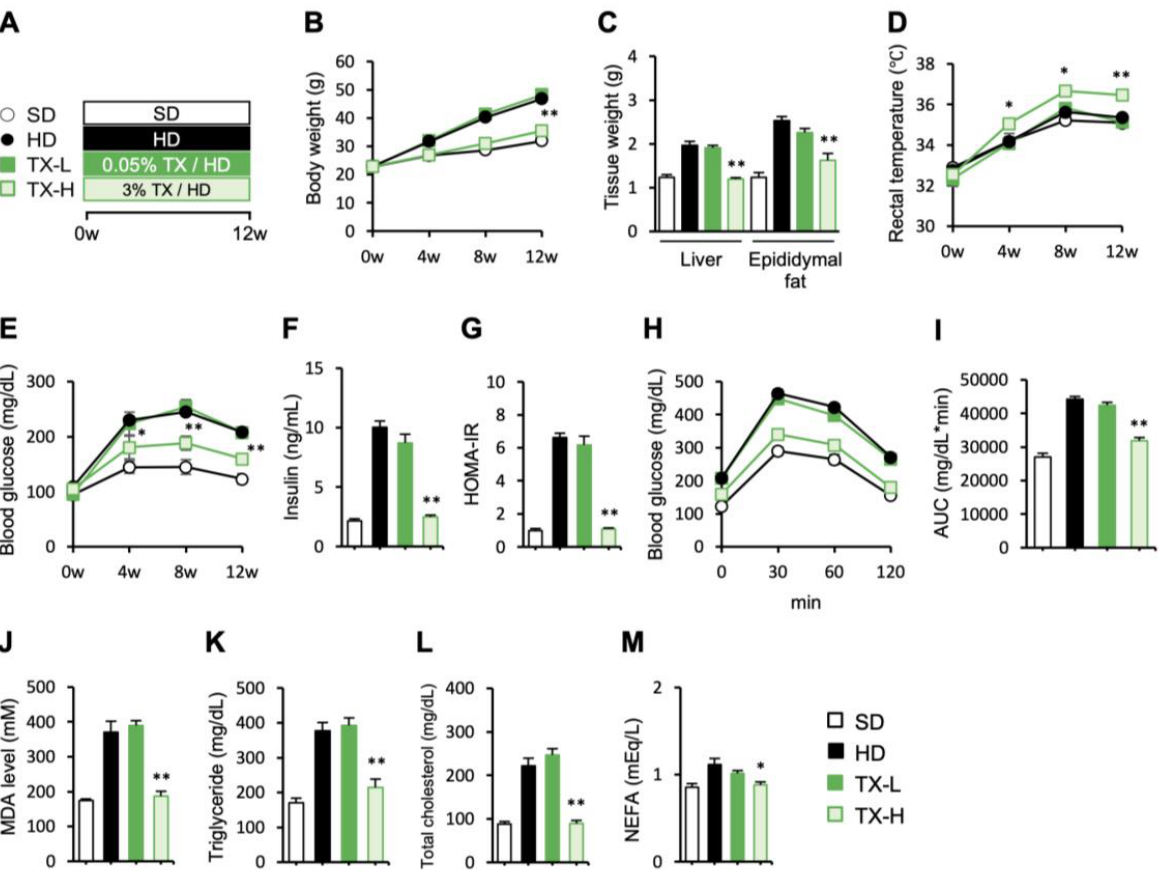
Figure 1. The preventive effects of Taxifolin on obesity and metabolic derangements in diet-induced obese mice. ( A ) Experimental protocol: male C57BL/6J mice were divided into the following 4 groups — SD group with a standard diet, HD group with a high-fat diet, TX-L group with a high-fat diet containing 0.05% (wt/wt) of Taxifolin, and TX-H group with a high-fat diet containing 3% (wt/wt) of Taxifolin. n = 6 in each group. ( B ) Growth curve; ( C ) tissue weights; ( D ) rectal temperature; ( E – G ) blood glucose levels ( E ), serum insulin concentrations ( F ), and homeostasis model assessment of insulin resistance (HOMA-IR) under fasting conditions ( G ); ( H , I ) intraperitoneal glucose tolerance test (injection of 1.0 g/kg of glucose) after 12 weeks of high-fat diet feeding: ( H ) blood glucose levels; ( I ) area under the curve (AUC) values for the blood glucose concentrations during the glucose tolerance test; ( J – M ) serum concentrations of malondialdehyde (MDA), triglyceride, total cholesterol, and nonesterified fatty acid (NEFA). Values are presented as the means ± SEM; significant differences: * p < 0.05 and ** p < 0.01 vs.